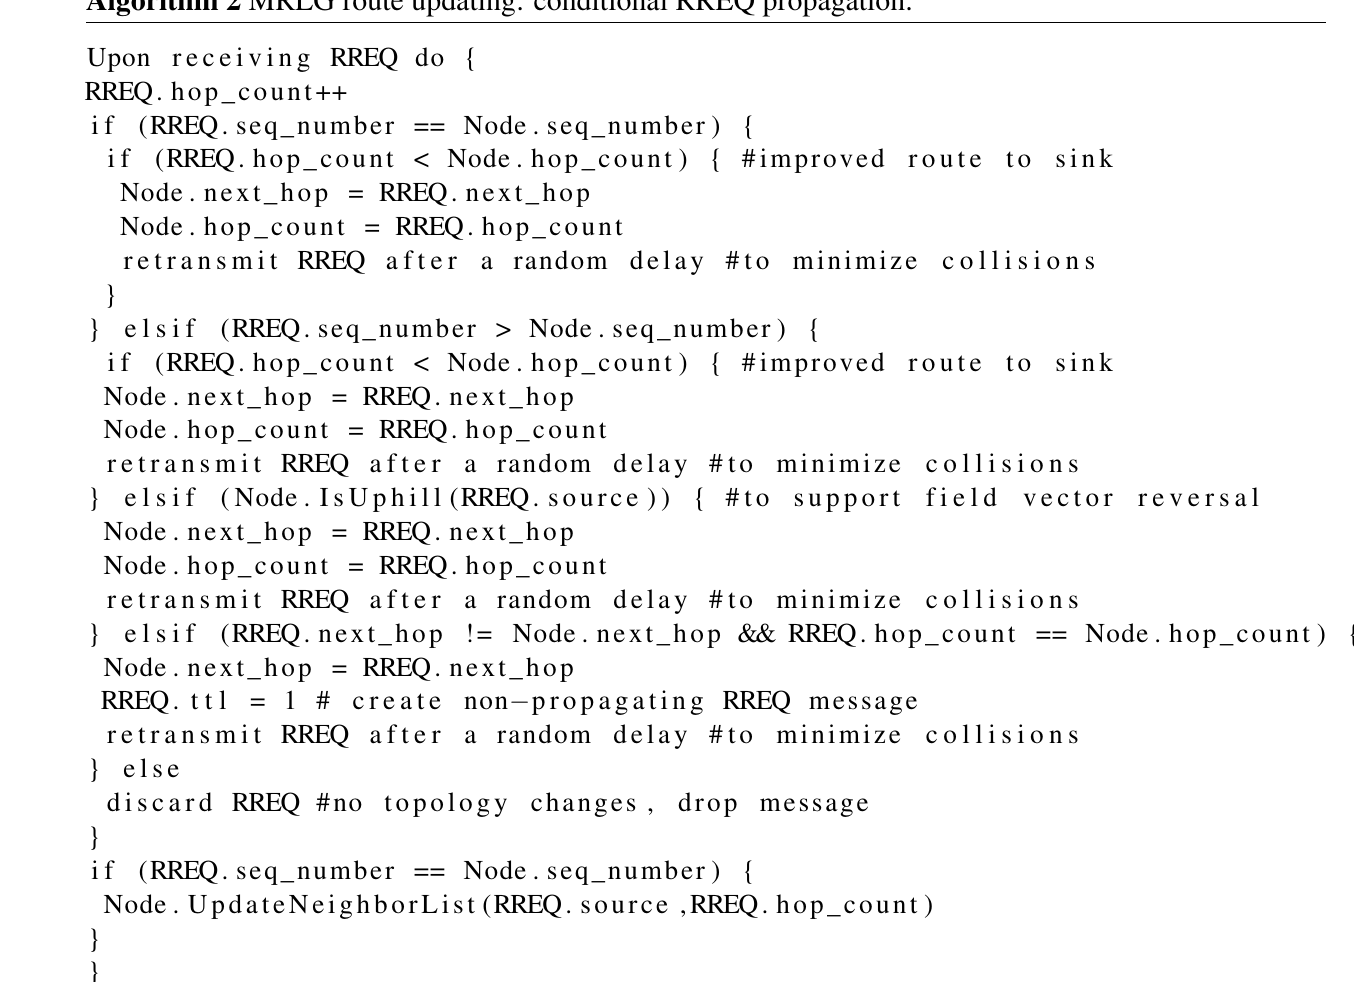
Algorithm 2 MRLG route updating: conditional RREQ